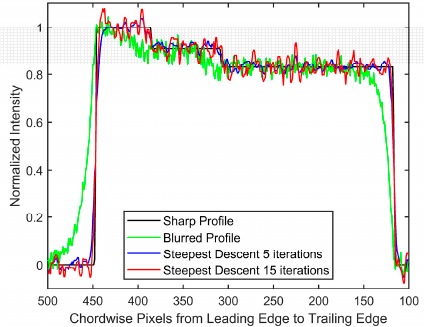
Figure 9. Effect of regularization iterations on restoration after nine iterations at r = 0.95. The x-axis represents pixels along the chord in polar coordinates. Rotation is toward increasing pixel values.